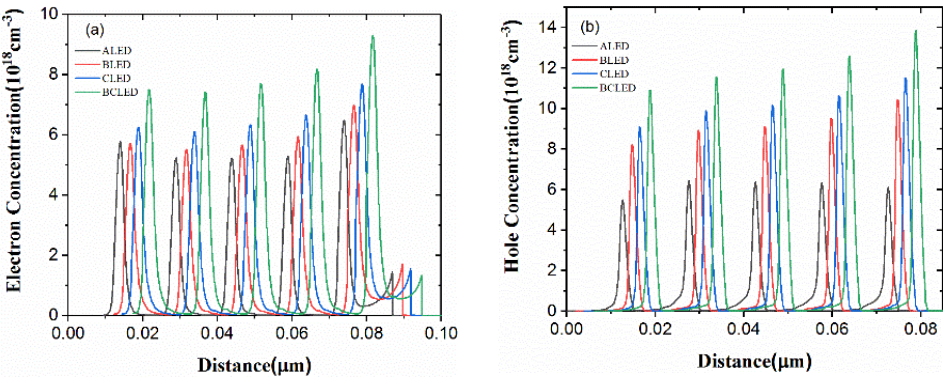
Figure 5. ( a ) Electron concentrations and ( b ) hole concentrations of the four structures at 400